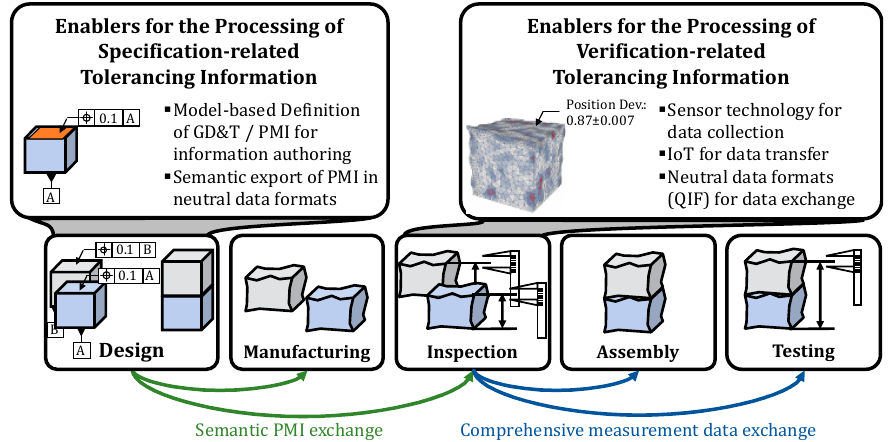
Figure 3. Main enablers for automatic tolerancing information processing. GD&T: Geometric Dimensioning and Tolerancing; PMI: Product Manufacturing Information; QIF: Quality Information